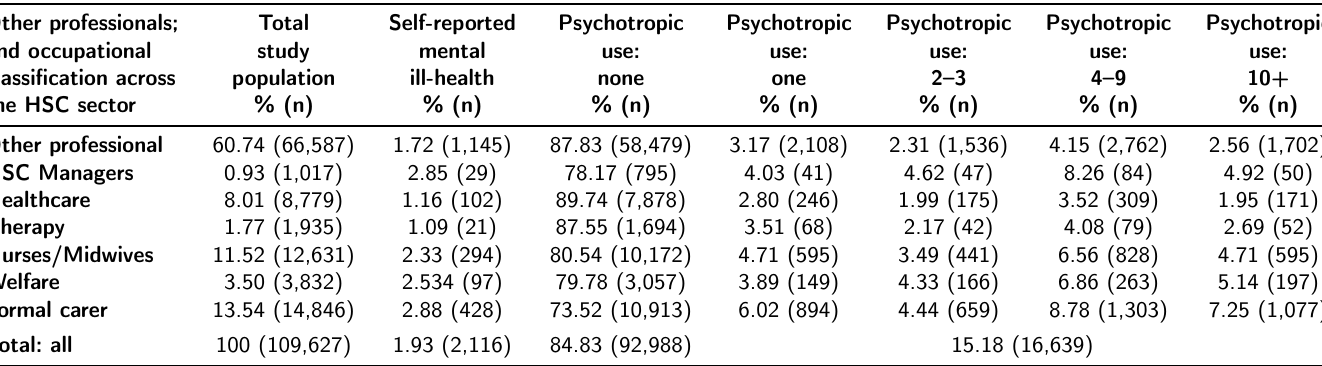
Table 1: Prevalence of (a) self-reported mental ill-health and (b) psychotropic prescription use (EPD, 2011–2012) across health and social care occupational classifications (recorded at the 2011 NI Census) Other